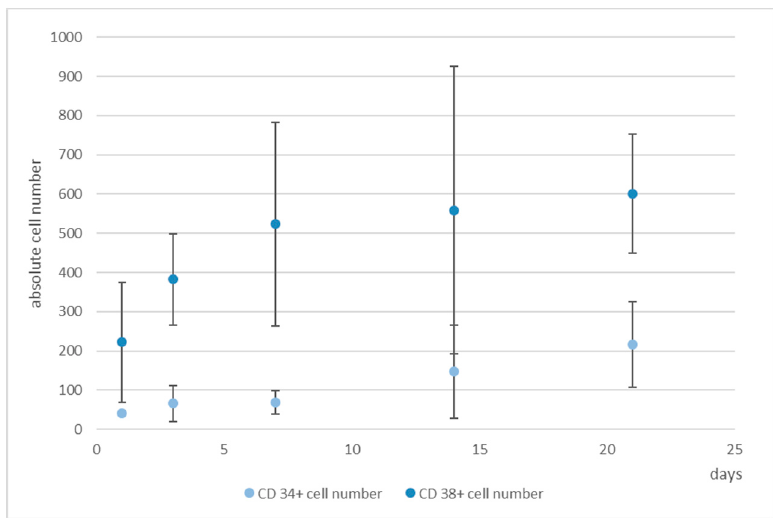
Figure 7. Numbers of CD34 + ( light blue ) and CD38 + cells ( medium blue ), determined by software- based counting, over a period of 21 days. Used antibodies for CD34 and CD38 cell detection: CD34 mouse anti-human-APC, AC136-APC, ThermoFisher Scientific, and CD38 monoclonal antibody (HIT2), FITC, eBioscience™, ThermoFisher Scientific.